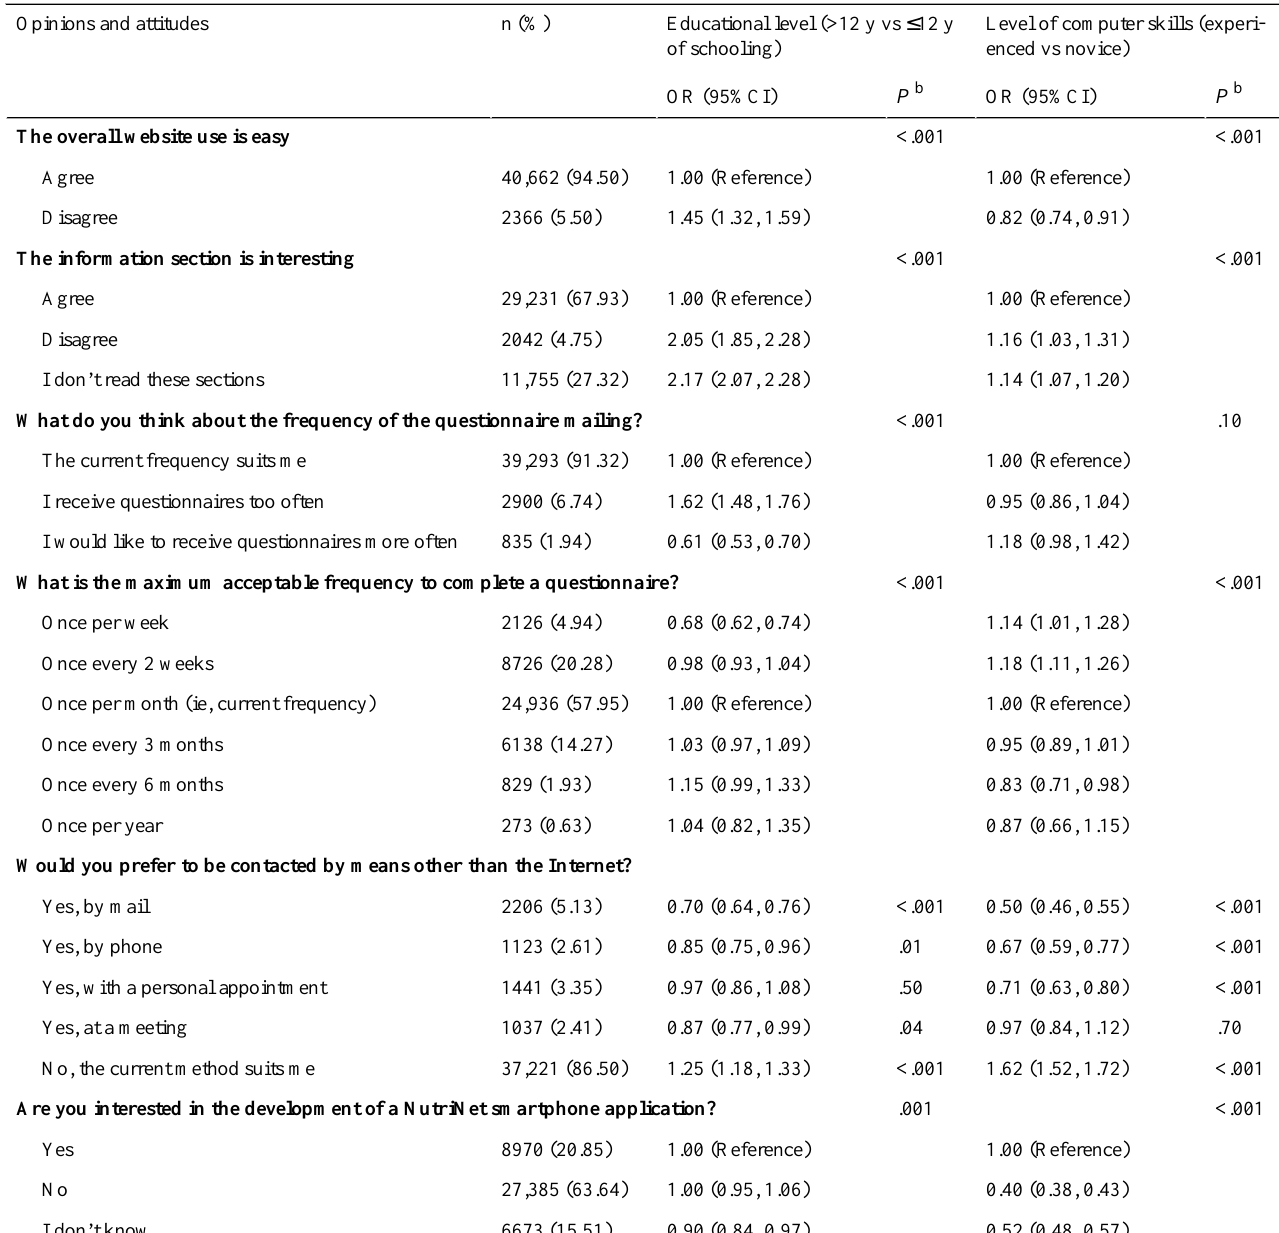
Table 4. Opinions and attitudes toward the NutriNet-Santé Study demands according to education and self-evaluated level of computer skills, NutriNet-Santé Study, France, 2013.